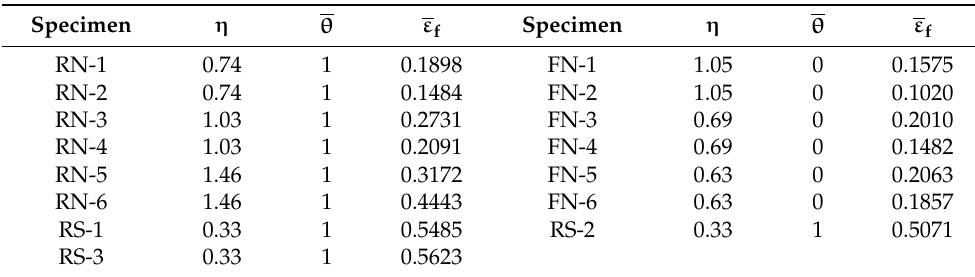
Table 1. Analysis of the test results with respect to the different parameters related to stress and